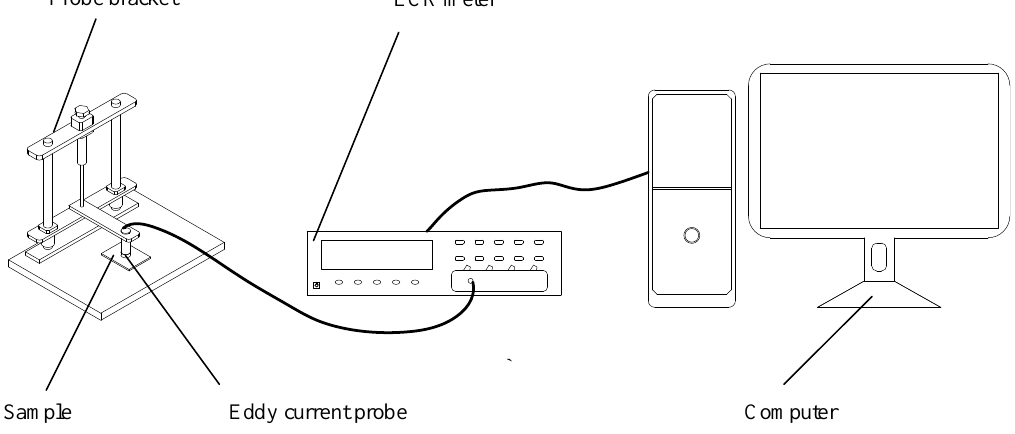
Figure 1. Schematic of eddy current testing setup.